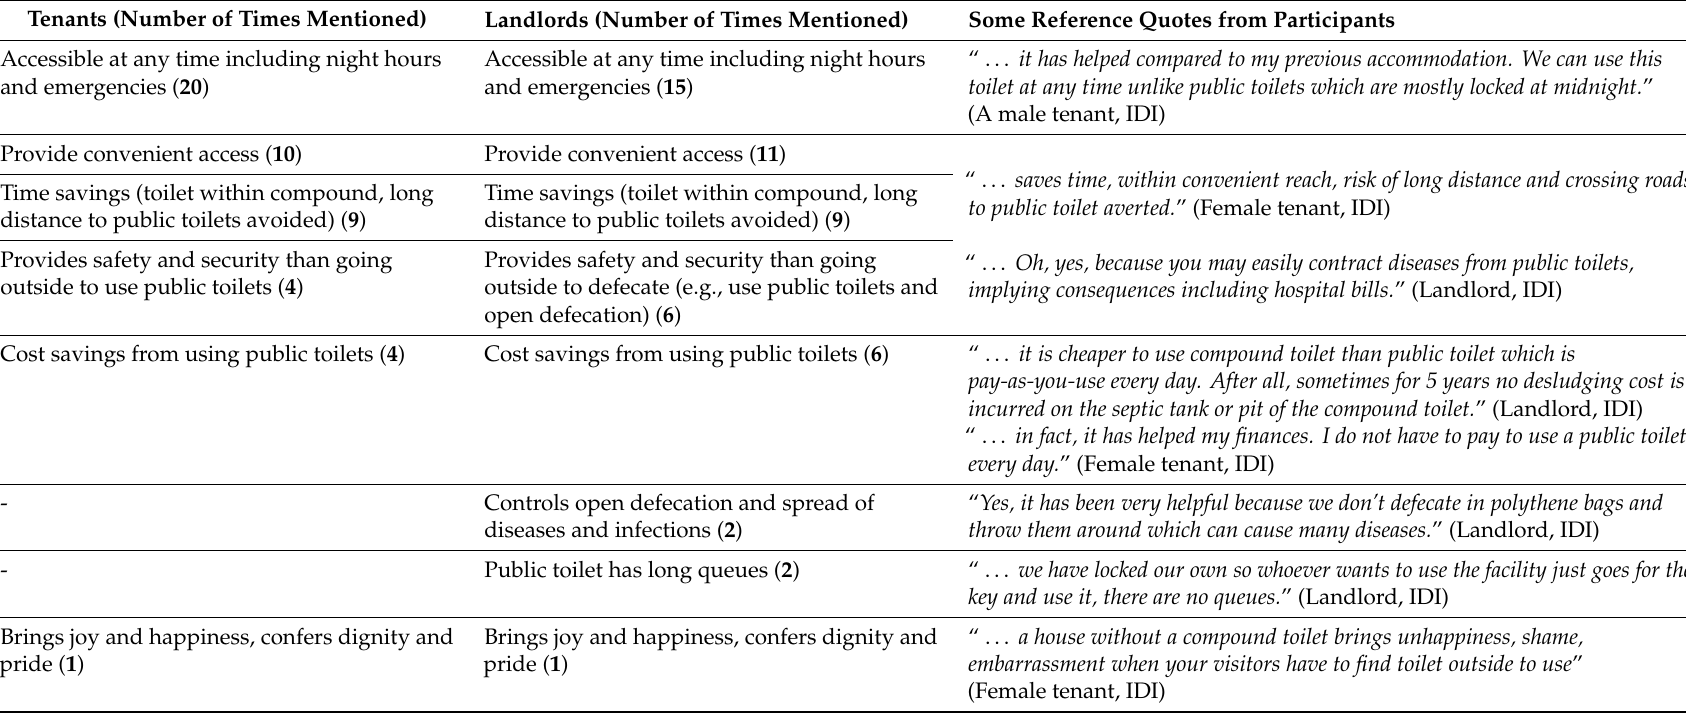
Table 2. Key benefits tenants and landlords derive from using compound shared toilet facilities